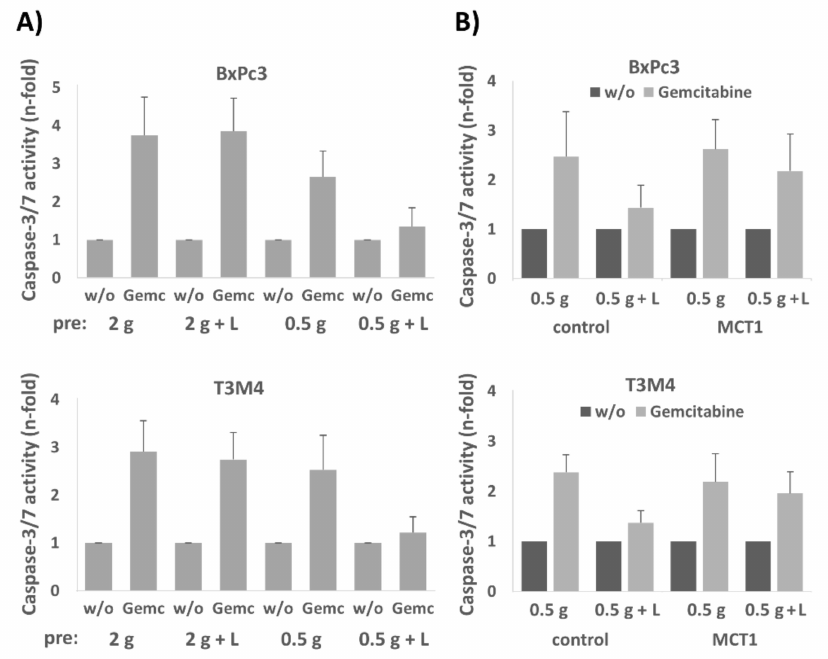
Figure 5. The presence of lactate during preculture under glucose restriction favours drug resistance of BxPc3 and T3M4 cells reseeded in normal medium. Deriving from 72 h preculture in the normal medium ± lactate (2 g, 2 g + L) or low glucose medium ± lactate (0.5 g, 0.5 g + L), BxPc3 and T3M4 cells, either ( A ) without or ( B ) with control and MCT1 siRNA pretreatment, were reseeded in normal medium for 24 h and were then left untreated or treated with 20 µ g / mL gemcitabine for 40 h. Gemcitabine induced apoptosis was analyzed by caspase-3 / 7 assay. Data are expressed as n-fold caspase-3 / -7 activity and show the mean values ± SD from three independent